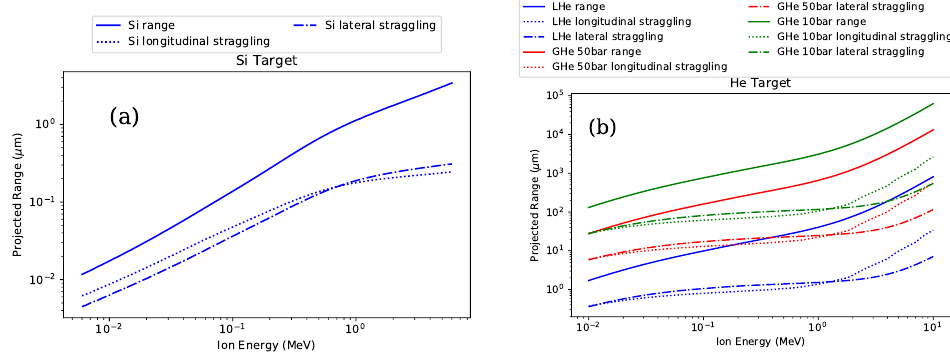
Figure 13. The ion range table using SRIM. ( a ) Silicon ion in silicon target. ( b ) Helium ion in 4 He target of liquid helium, gas helium of 50 bar, and gas helium of 10